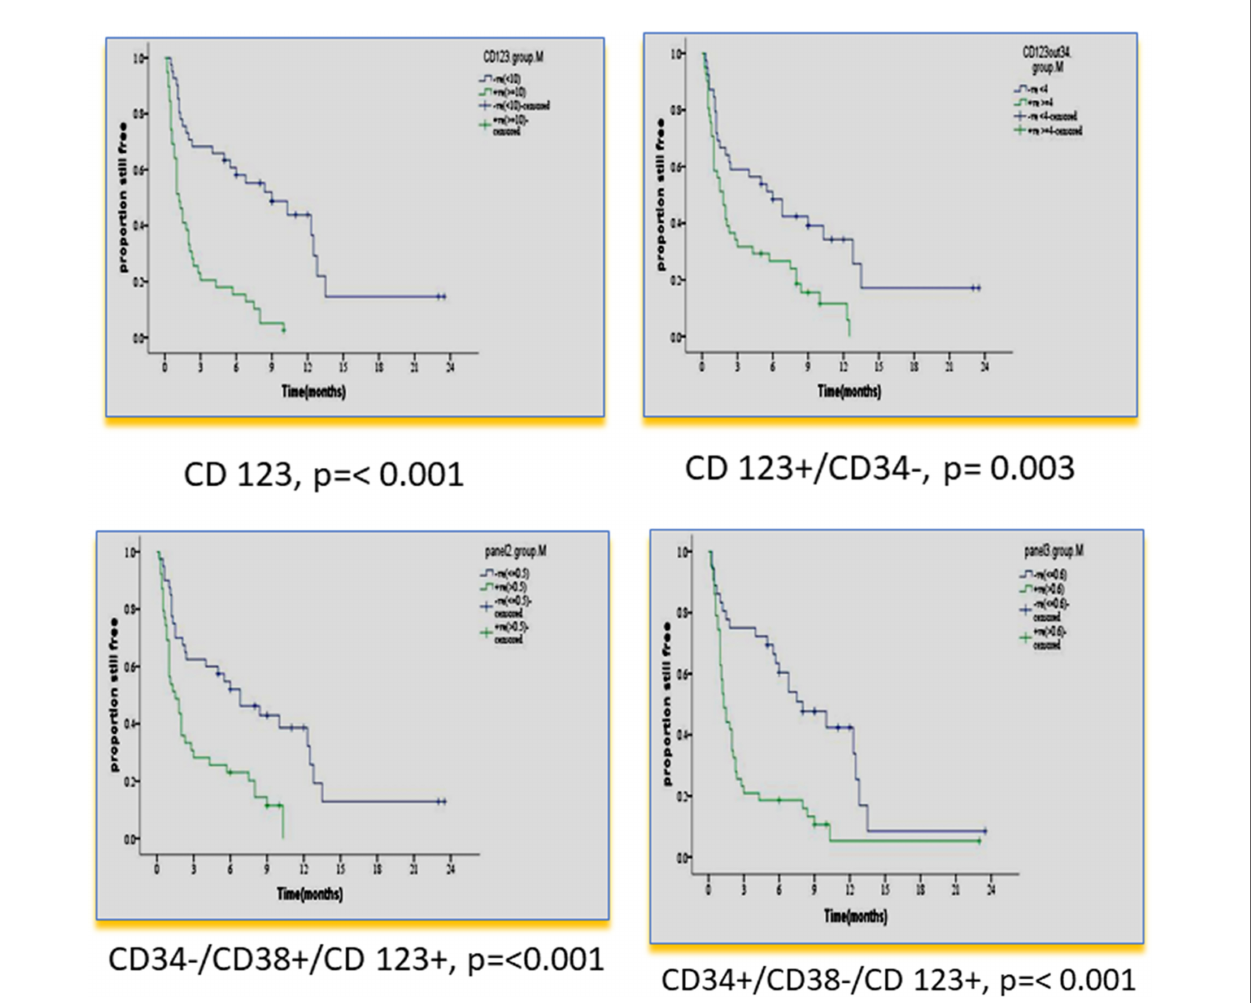
FIGURE 3 | Impact of leukemia stem cell marker(s) at diagnosis on disease-free survival in 80 adult acute myeloid leukemia patients by using panel CD38 FITC/